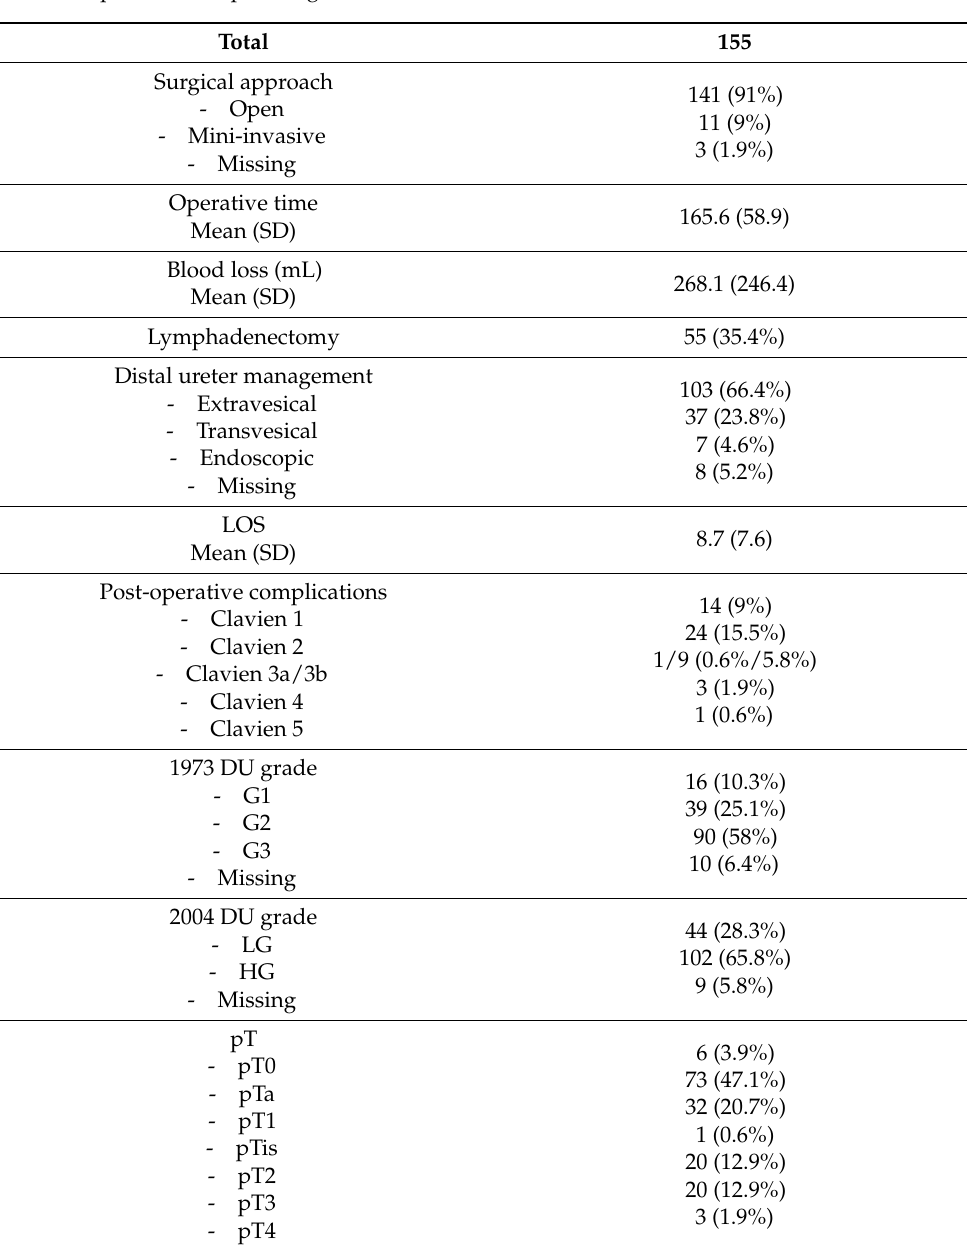
Table 2. Operative and pathological